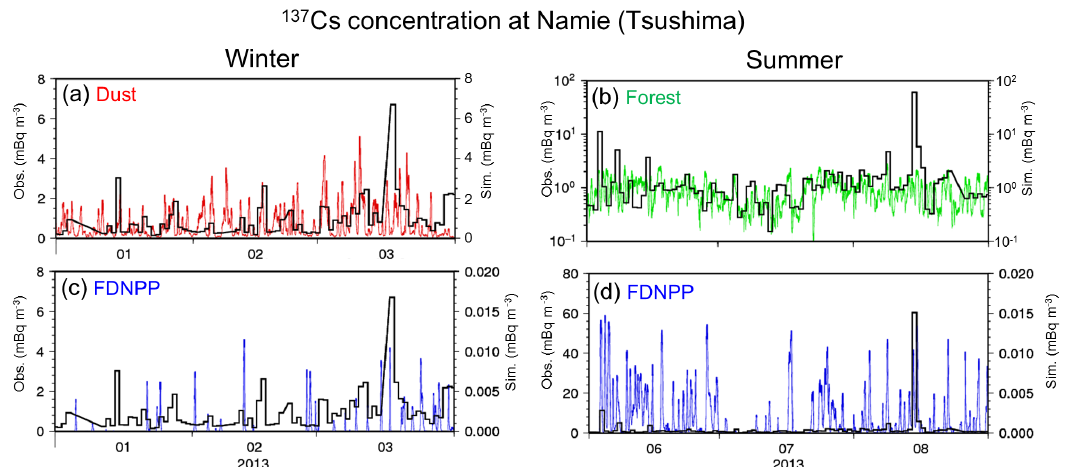
Figure 9. Time series of observed (black) and simulated (colors) 137 Cs surface air concentration at Namie ( a , c ) in winter from January to March and ( b , d ) in summer from June to August 2013. The colors of the lines are the same as in Fig. 7 but the time variation is hourly. The shaded areas indicate the range of 137 Cs concentrations obtained when the simulations were run using the optimized parameter ranges E c = 0.03–0.05 and v d = 0.05–0.1cms − 1